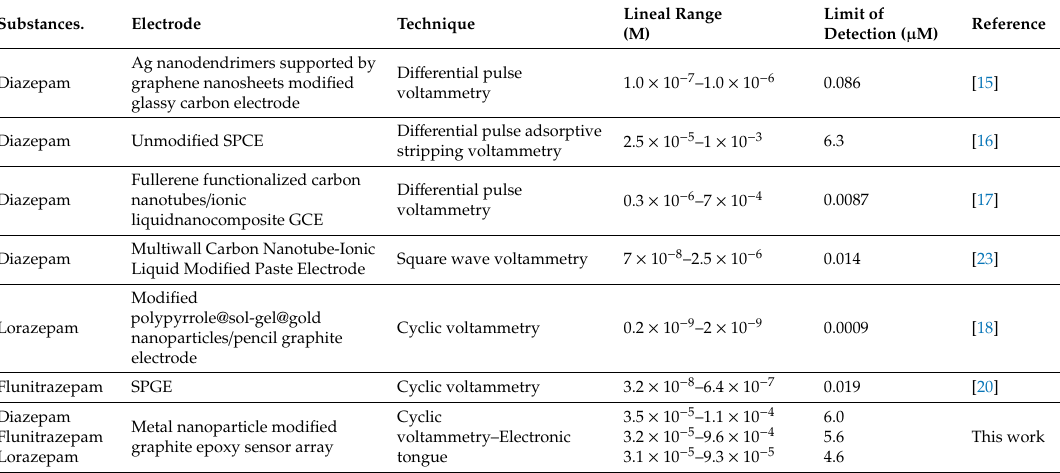
Table 2. Analytical results of the work presented herein and most relevant references, This table compares the substances detected, the sensor and employed electrochemical technique, the linear range, and the limit of